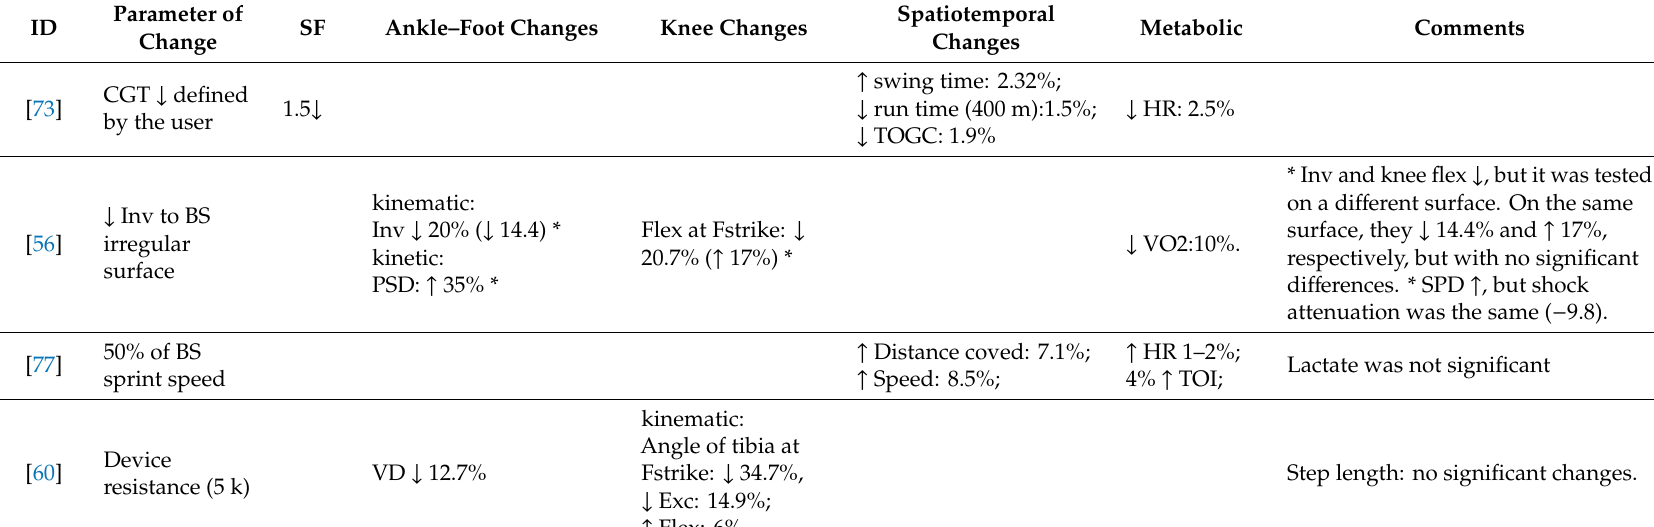
Table 7. Biomechanics changes produced by articles that provided feedback based on uncommon